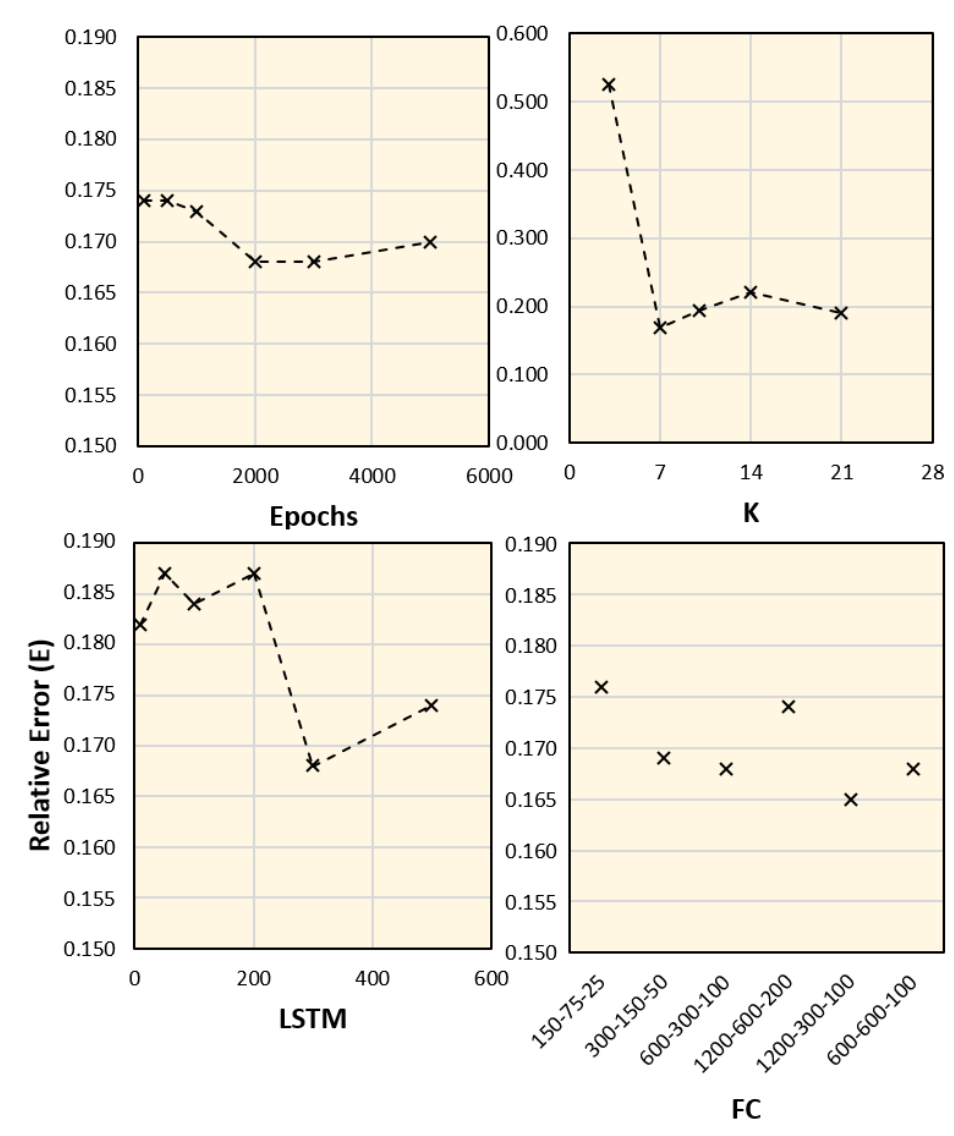
Figure 11. Relative error ( E ) for different parameter setups shown in Figure 10.